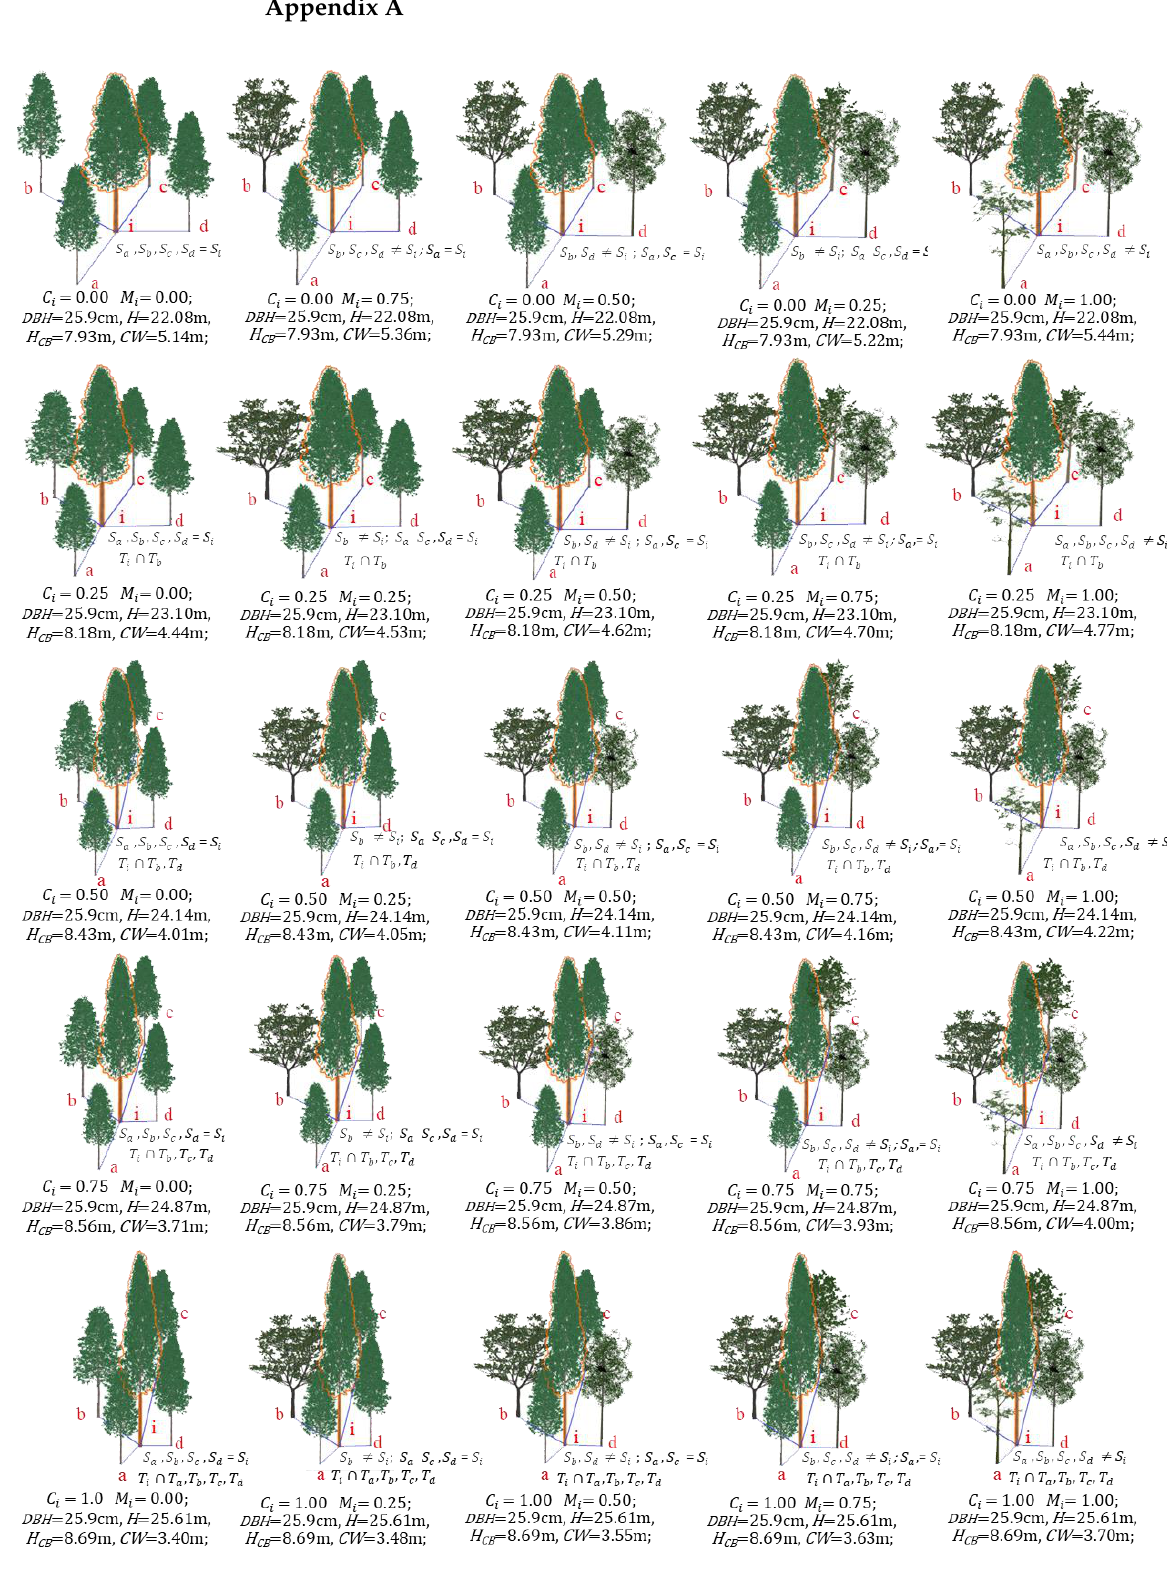
Figure A1. Three-dimensional modeling of SM under different 𝐶 𝑖 and 𝑀 𝑖 . The values of 𝐶 𝑖 and 𝑀 𝑖 were 0.00, 0.25, 0.50, 0.75, and 1.00. Since Cunninghamia lanceolata (SM) ( DBH = 25.9 cm) occurred most frequently in the study region, we chose it as an example.